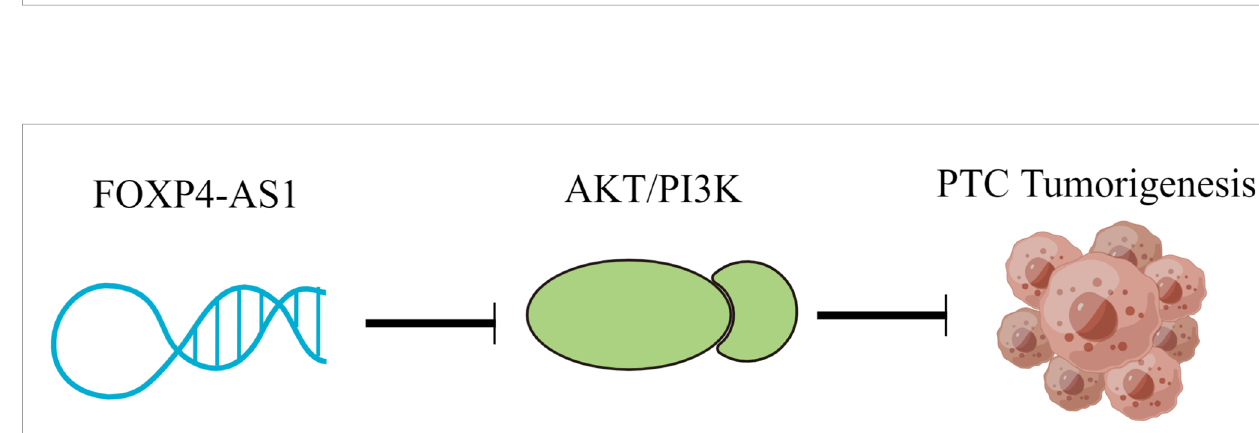
FIGURE 7 | Akt inhibitor can reverse the promoting effect of siFOXP4-AS1 on papillary thyroid cancer cell lines. (A) The inhibitory ef fi ciency of MK2206 to p-AKT. (B) The effect of siFOXP4-AS1 on PTC cell viability was attenuated by AKT inhibitor MK2206. (C) The effecting of siFOXP4-AS1 on PTC cell colony numbers was attenuated by MK2206. (D) The effect of MK2206 on siFOXP4-AS1-mediated apoptosis. * p <0.05, ** p <0.01.